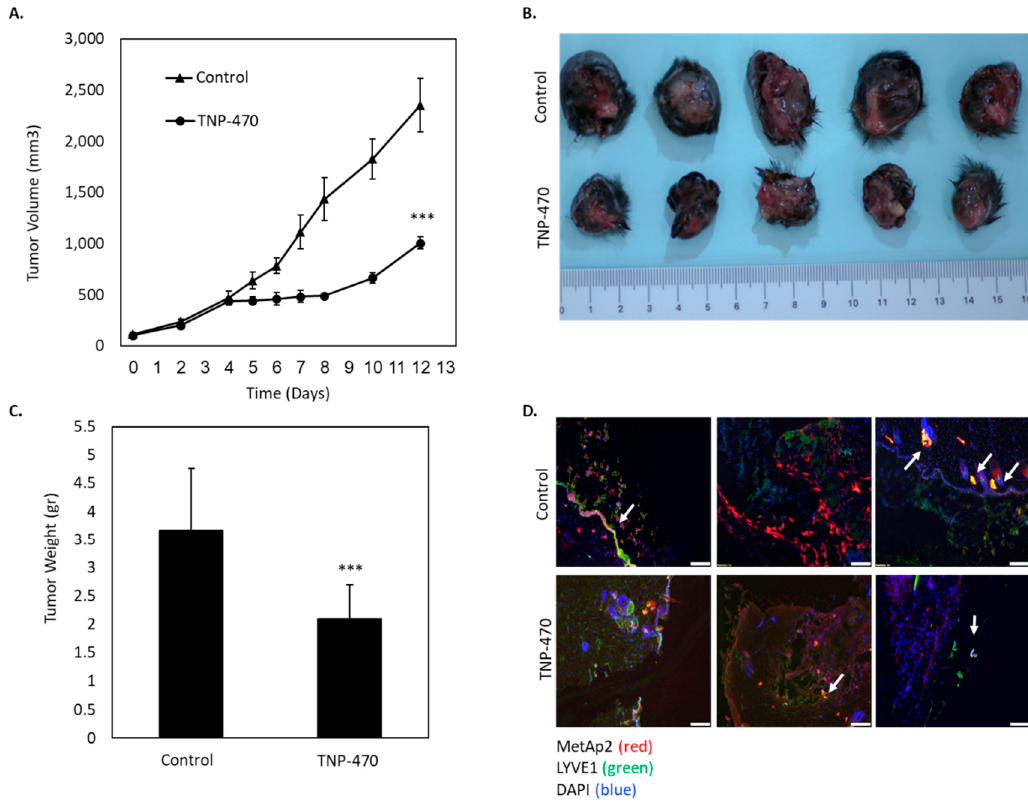
Figure 7. MetAp2 inhibition suppresses the growth of murine melanoma tumors. C57 / BL6J mice were injected S.C. with B16 / F10 cells, overexpressing VEGF-C (1.5 × 10 6 cells / tumor). The mice were divided into two groups, untreated and treated with TNP-470 (30 mg / kg q.o.d). n = 8–10. ( A ) The tumor volume after 12 days of treatment with TNP-470 was significantly lower (2.3-fold) when compared with the untreated group. *** p < 0.005. ( B ) Representative images of tumors extracted from the untreated and treated groups after 12 days of TNP-470 treatment. ( C ) The mean weight of the tumors extracted from the untreated and treated mice following 12 days of TNP-470 treatment. n = 8. *** p < 0.005. ( D ) Immunofluorescent staining for MetAp2 (red), LYVE1 (green) and DAPI (blue) shows lymphatic structures (white arrows). The results are presented as mean ± SEM. Scale bar = 100 µm.